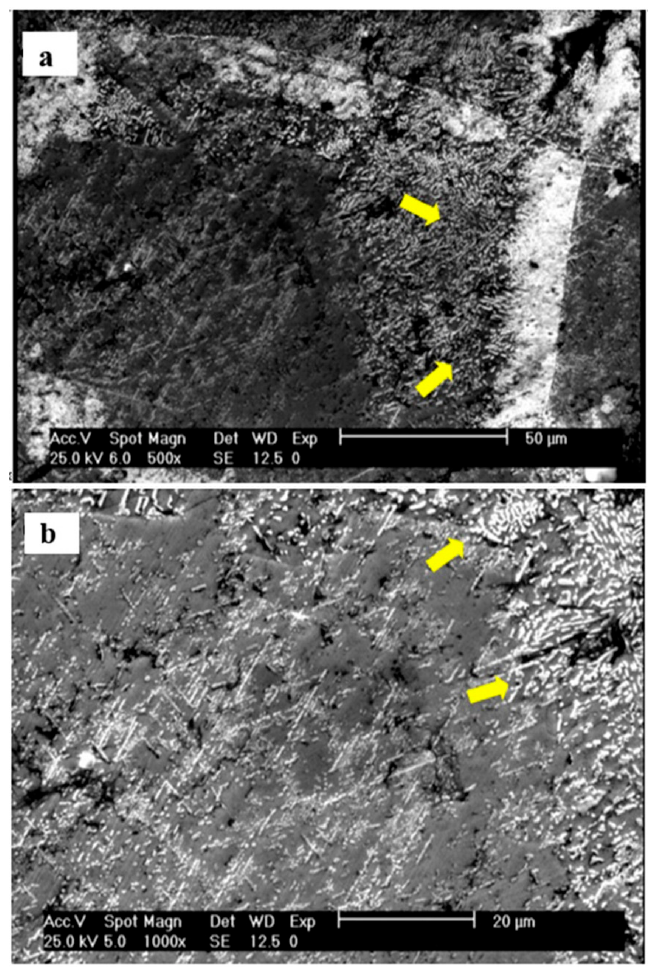
Figure 6. SEM micrographs of the sample solution treated at 1230 ° C for 3 h and aged at 850 °C for 48 h, ( a ) lamellar carbides ( b ) progressive formation of carbides on the HCP 1 phase during